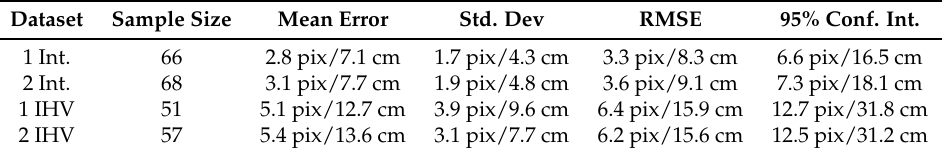
Table 6. Summary of the error results (mean, standard deviation, root-mean-square error and 95% confidence interval) for the different trained VGG-16 networks. Both the errors, in pixels and centimeters, are displayed, taking into account the GSD of 2.5